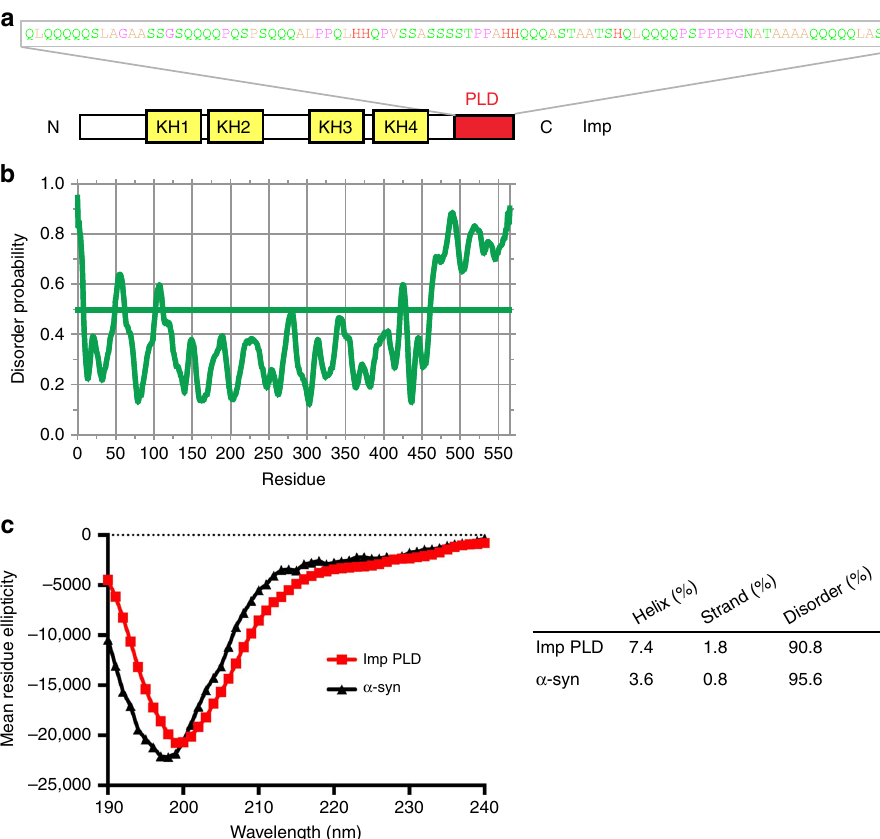
Fig. 1 Drosophila Imp contains a C-terminal prion-like domain (PLD). a Schematic representation of Drosophila Imp (PB isoform). The four KH RNA-binding domains are shown in yellow, and the prion-like domain (PLD) in red. Residues composing the prion-like domain are colored according to their physicochemical properties (Zappo color code). b Plot of the degree of disorder along the Imp protein, as predicted by the DisEMBL Intrinsic Protein Disorder Prediction 1.5 algorithm. c Far ultraviolet circular dichroïsm spectrum of the PLD of Imp (red). The spectrum of α -Synuclein ( α -Syn, black) is shown for comparison. Predicted fractions of structured and unstructured regions are shown in the table for both peptides. Source data are provided as